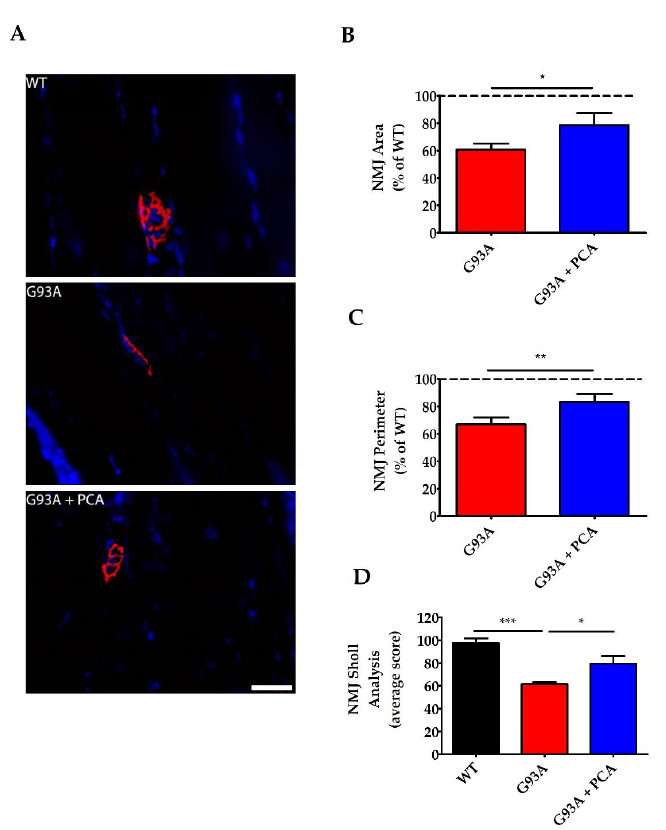
Figure 8. PCA treatment significantly preserves neuromuscular junctions (NMJ) in the gastrocnemius muscle in the hSOD1 G93A mouse model of ALS. ( A ) Representative images of gastrocnemius muscle from wildtype control mice (WT), untreated hSOD1 G93A mice (G93A), and hSOD1 G93A mice treated orally with 100 mg / kg PCA beginning at disease onset (G93A + PCA). Mice were euthanized at end stage of the untreated hSOD1 G93A littermate mouse and gastrocnemius muscles were stained with alpha-BTx (red) and Hoechst (blue) to label NMJs and nuclei, respectively. Scale bar = 40 µ m. ( B ) Quantification of gastrocnemius NMJ area stained with alpha bungarotoxin as described in A. The NMJ area, measured in pixels by tracing the outside of the neuromuscular junction, of untreated and PCA-treated hSOD1 G93A littermate mice were normalized and expressed as a percentage of NMJ area measured in the WT littermate control mouse. Data are expressed as the mean ± SEM; n = 8 mice per group; 20–25 NMJs were imaged per mouse. * indicates p < 0.05 compared to untreated hSOD1 G93A control mice (paired t -test). Mean NMJ pixel area for the untreated hSOD1 G93A littermate mouse (11,842 ± 1204) is significantly less than the WT littermate control mouse (17,966 ± 818) ( p = 0.01; n = 8 mice per group). ( C ) Quantification of gastrocnemius NMJ perimeter stained with alpha bungarotoxin as described in A. The NMJ perimeter, measured in pixels by tracing the inside and outside of the NMJ, of untreated and PCA-treated hSOD1 G93A littermate mice were normalized and expressed as a percentage of NMJ perimeter measured in the WT littermate control mouse. Data are expressed as the mean ± SEM; n = 9 mice per group; 20–25 neuromuscular junctions were imaged per mouse. ** indicates p < 0.01 compared to untreated hSOD1 G93A controls (paired t -test). Mean NMJ pixel perimeter for the untreated hSOD1 G93A littermate mouse (730.9 ± 39.37) is significantly less than the WT littermate control mouse (1141 ± 94.52) ( p = 0.0007; n = 9 mice per group). ( D ) Quantification of gastrocnemius NMJ Sholl analysis stained with alpha bungarotoxin as described in A. WT, untreated, and PCA-treated hSOD1 G93A littermate mice were given a mean Sholl analysis value, which represents the number of intersections that the NMJ makes with concentric circles every 10 pixels from a center point. Data are expressed as the mean ± SEM; n = 8 mice per group; 20–25 neuromuscular junctions were imaged per mouse. * indicates p < 0.05 and *** indicates p < 0.001 compared to WT littermate control mice (one-way ANOVA with post-hoc Tukey’s